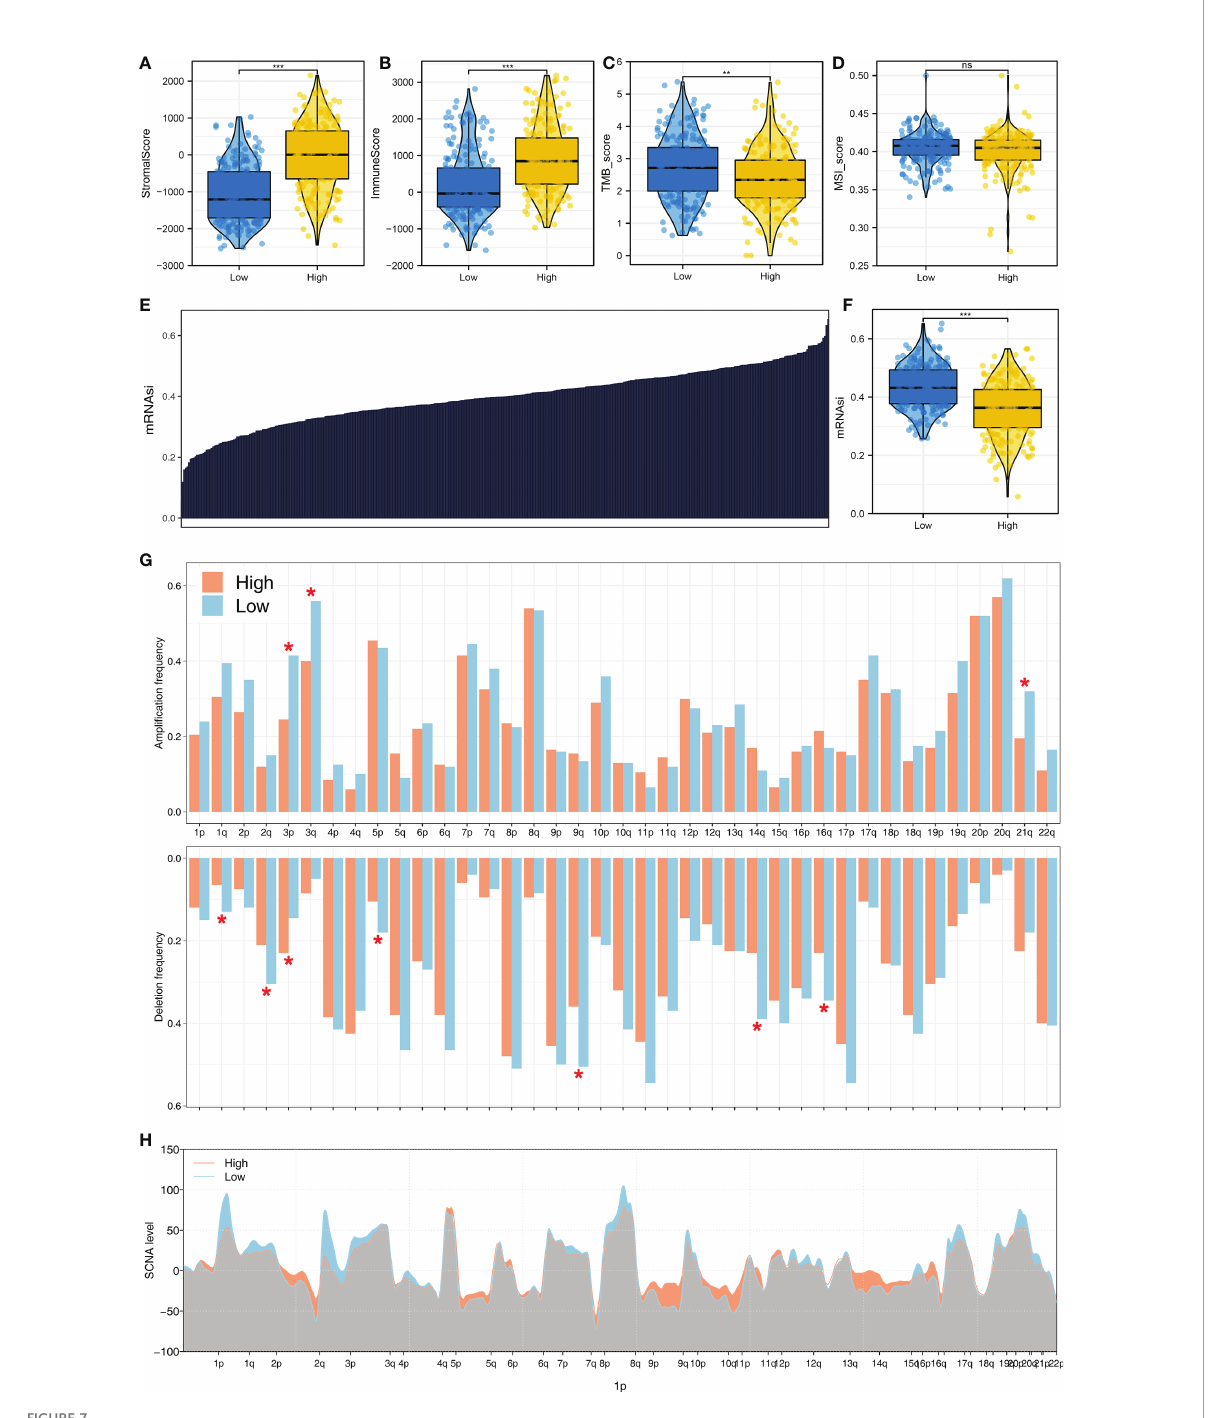
FIGURE 7 The genomic difference in patients with a high and those with a low logistics score (A) Level of stromal score in patients with a high and those with a low logistics score. (B) Level of immune score in patients with a high and those with a low logistics score. (C) Level of TMB score in patients with a high and those with a low logistics score. (D) Level of stromal score in patients with a high and those with a low logistics score. (E) The obtained mRNAsi in the TCGA database. (F) Level of mRNAsi score in patients with a high and those with a low logistics score. (G, H) Comparisons of arm-level ampli fi cation and deletion frequencies and focal-level ampli fi cation and deletion levels in patients with high and those with low logistics scores. *P < 0.05, **P < 0.01, ***P < 0.001. ns: P >